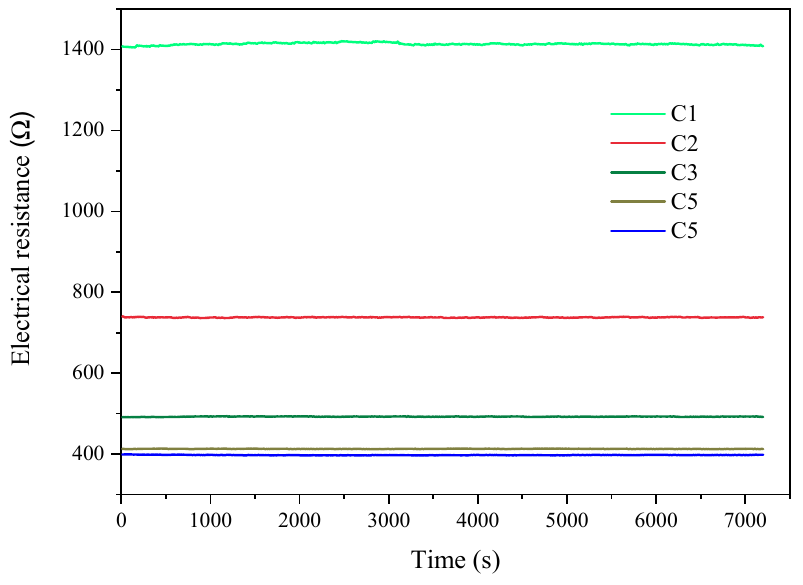
Figure 3. The stability of the measurement (C1 to C5 denote the concrete samples).